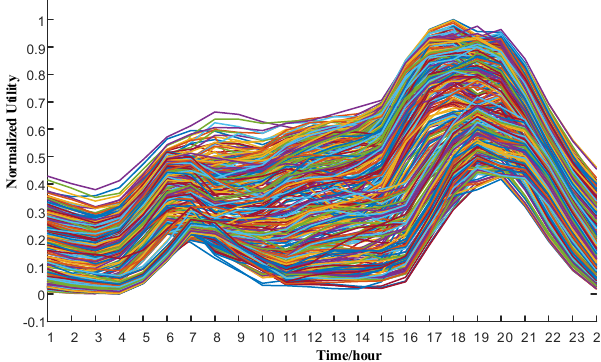
Figure 8 . Customers’ utility feature in one day. Figure 8. Customers’ utility feature in one